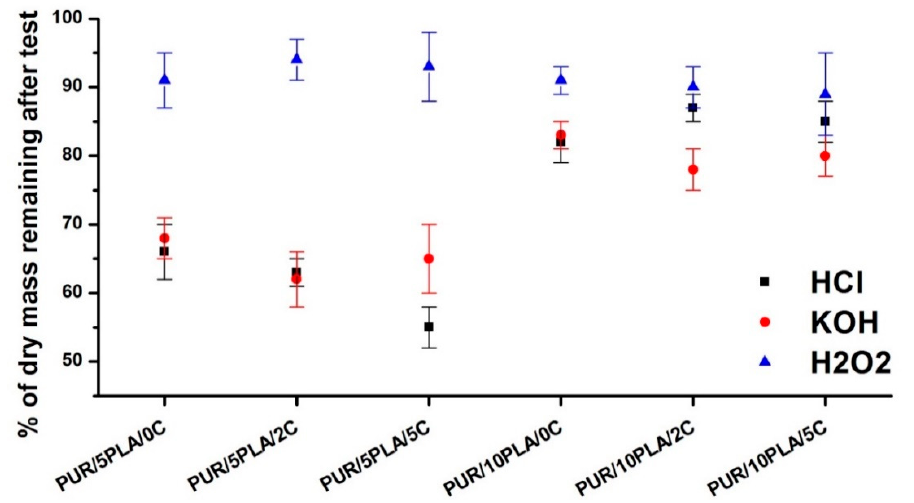
Figure 7. Dry residue (%) of unmodified and Cipro-modified HPPS, obtained by using 5 or 10 wt % of PLA after 15 days of incubation in selected media: 2 N HCl, 5M KOH, and 0.1 M CoCl 2 in H 2 O 2.